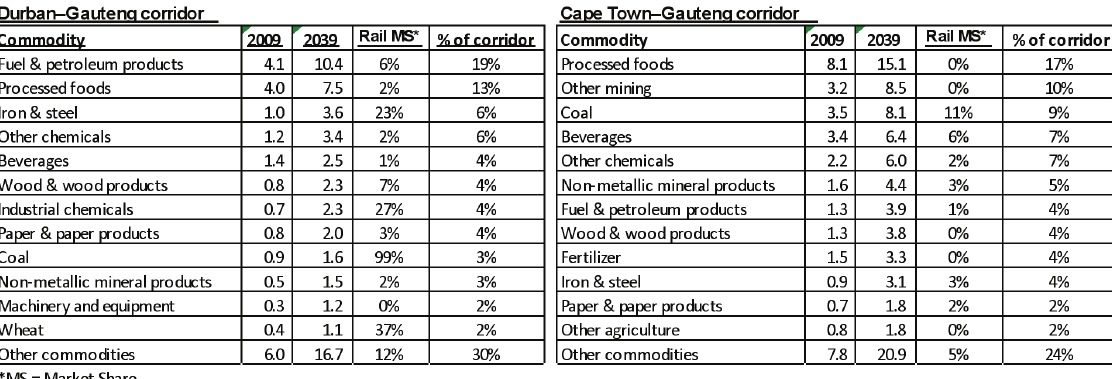
Table II: Pareto analysis (based on 2039 ton-km) of commodities for the two target corridors (billion ton-km) (data source: FDM, 2009)